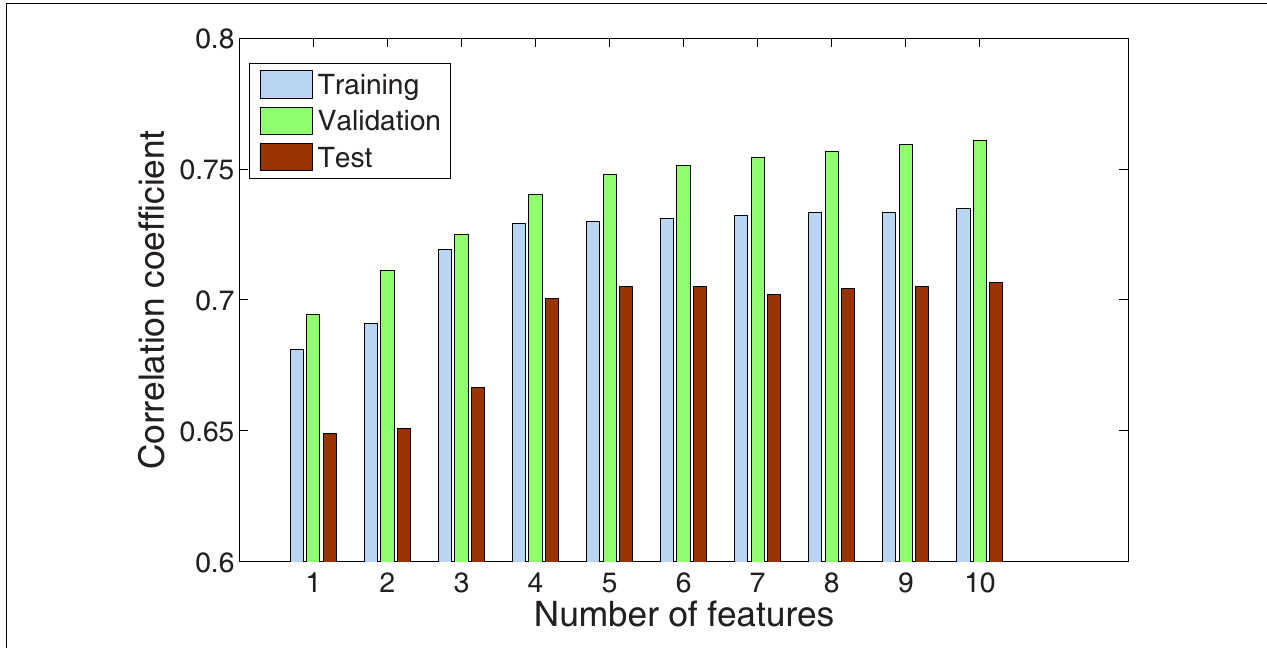
FIGURE 2 | Evolution of the performance for the index finger of subject 1 according to the number of features given by the forward feature